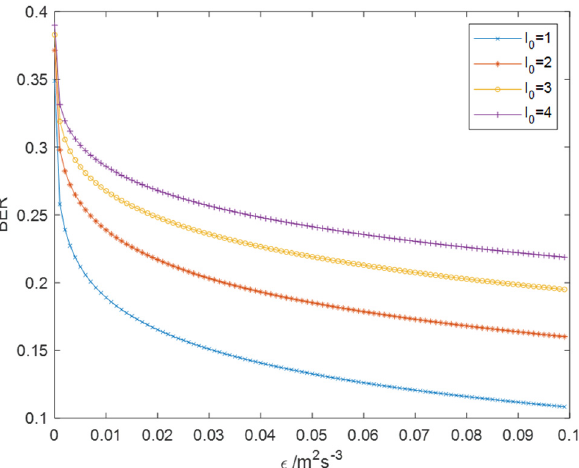
Figure 4. BER of the coaxial double-position power Gaussian vortex carrier communication link versus dissipation rate of kinetic energy per unit mass of fluid ε for different topological charge of vortex.